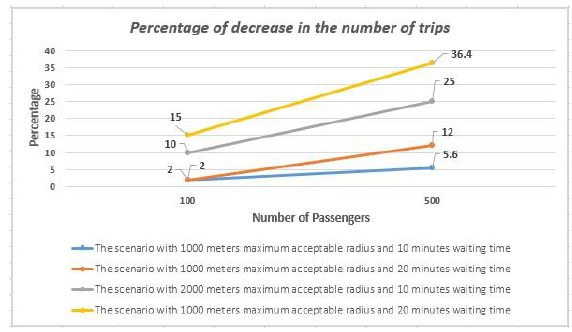
Figure 5. Percentage of decrease in the number of trips